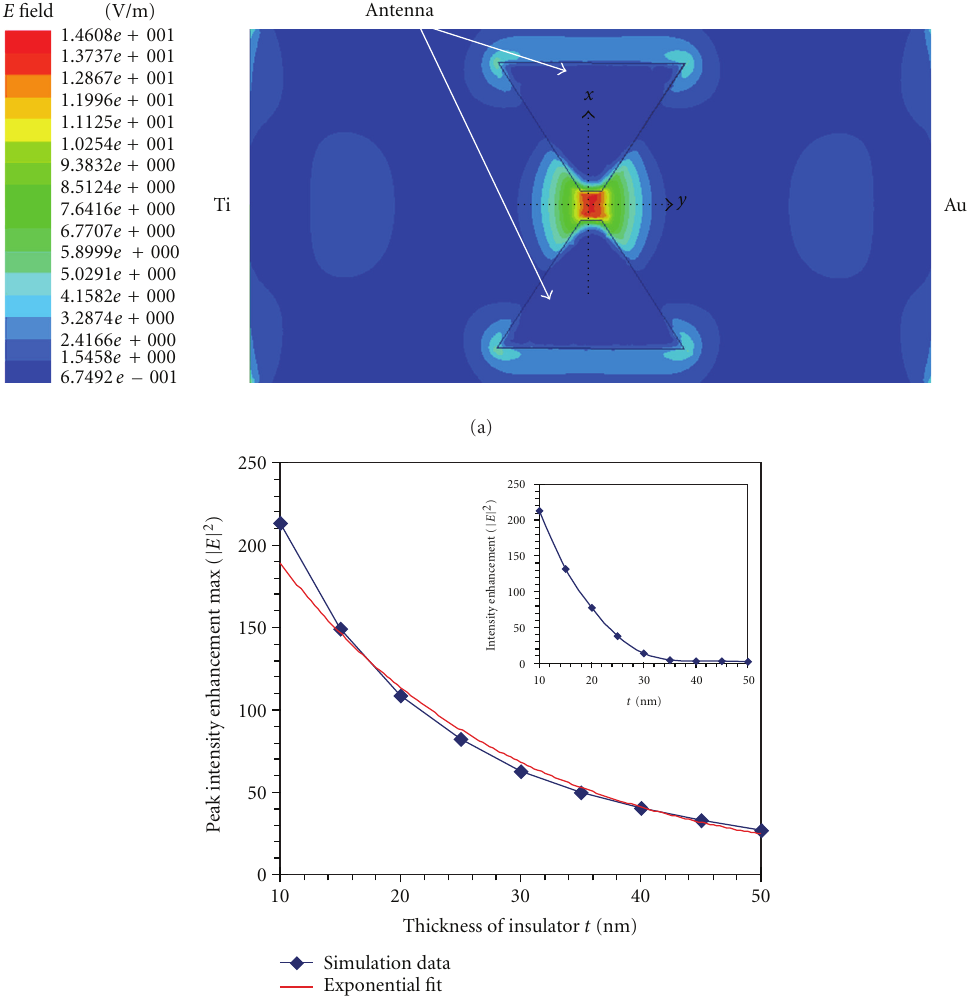
Figure 3: (a) The E -field distribution of the resonance frequency (845nm) of the bowtie antenna with θ = 60 ◦ , and t = 10 nm. The x − y axis show the coordinate for simulation. (b) The t dependent peak field intensity max ( | E | 2 ), blue curve is the simulation values, and red curve is the exponential fit. The inset shows field intensity enhancement | E | 2 at wavelength of 830